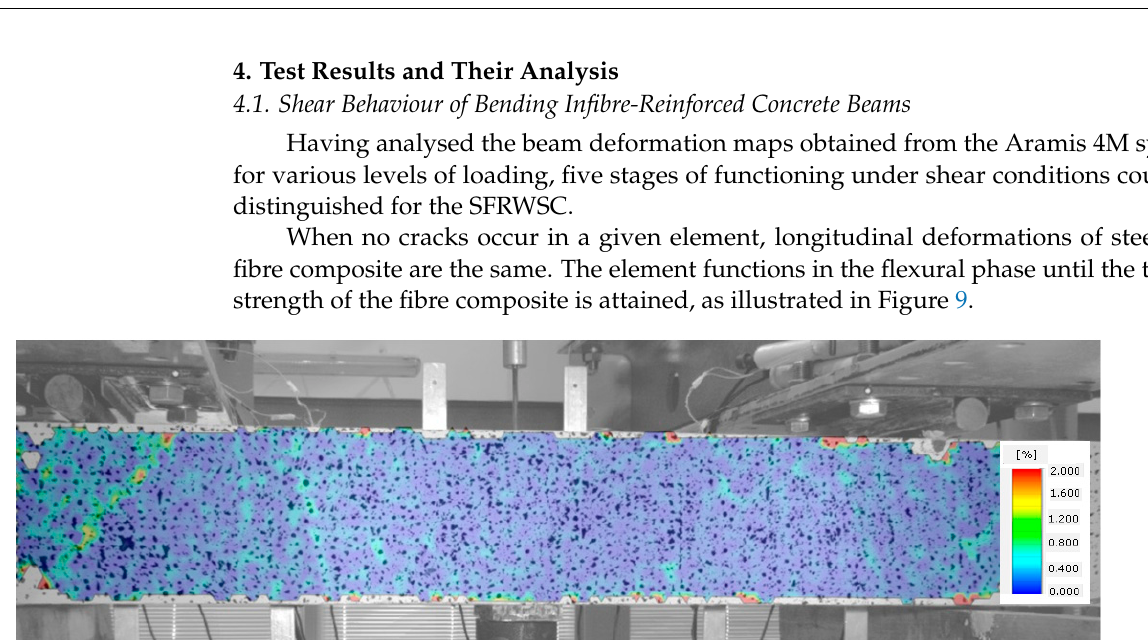
Figure 8. Beam reinforced with steel corset after the first testing stage.